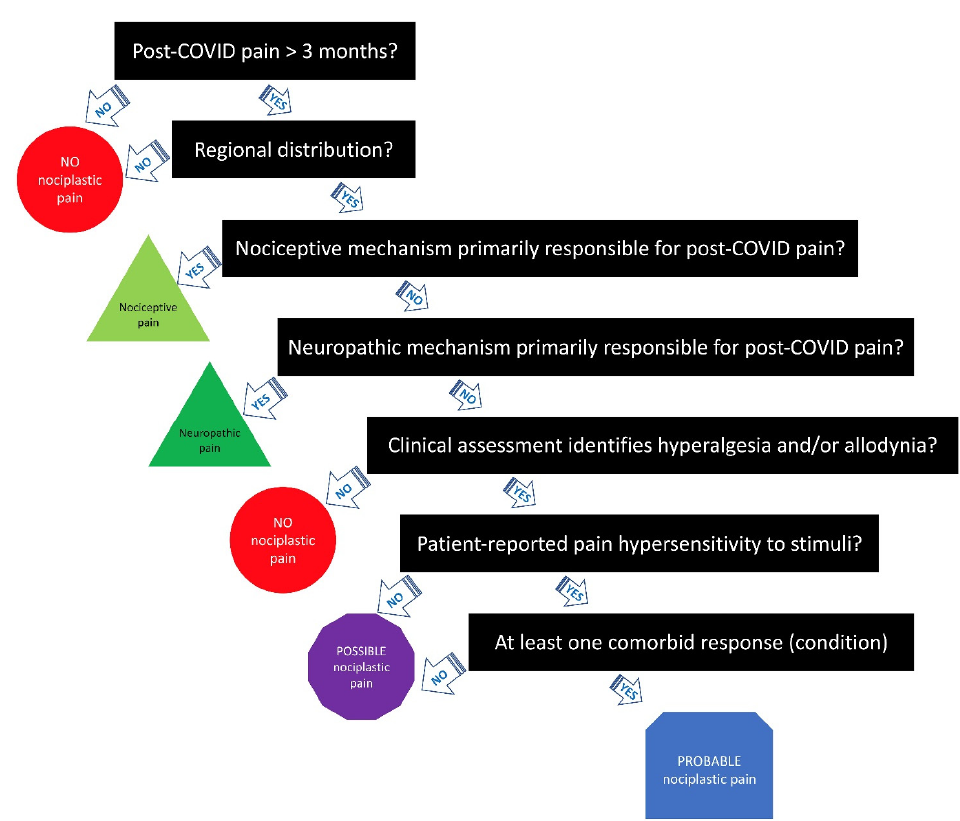
Figure 1. Clinical decision ‐ making tree of the IASP clinical criteria for nociplastic pain applied to post ‐ COVID pain.